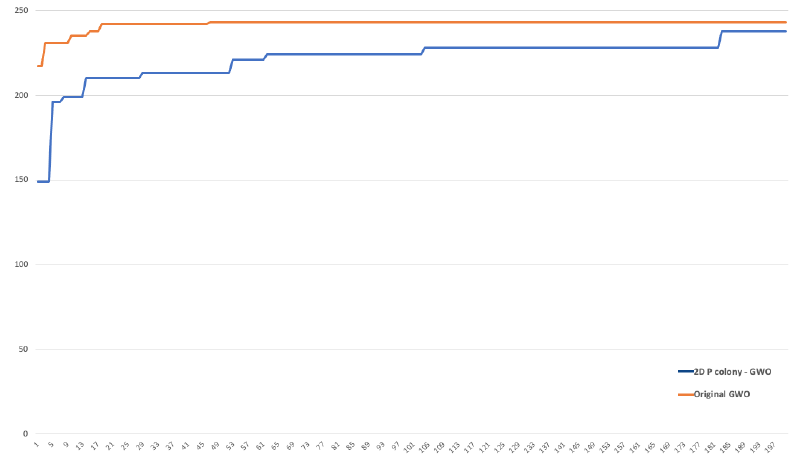
Figure A2. Results of testing function F 2 .